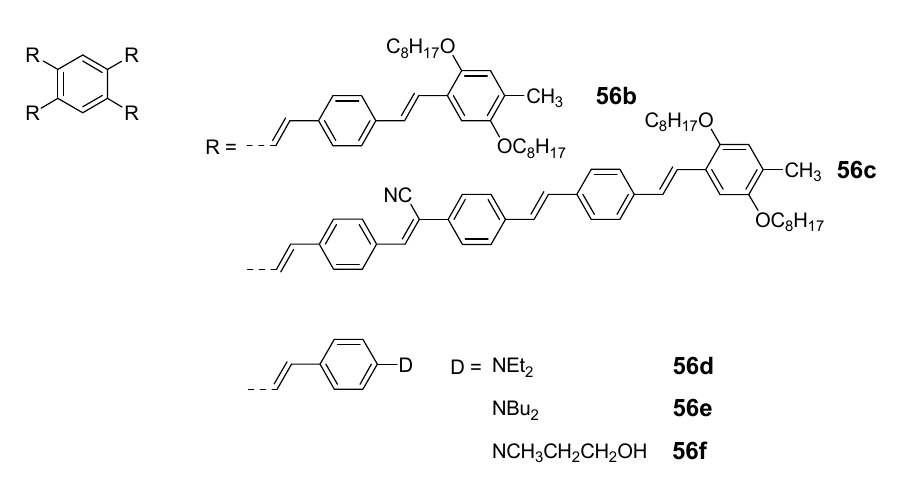
Figure 20. Stilbenoid materials for OLED and TPA